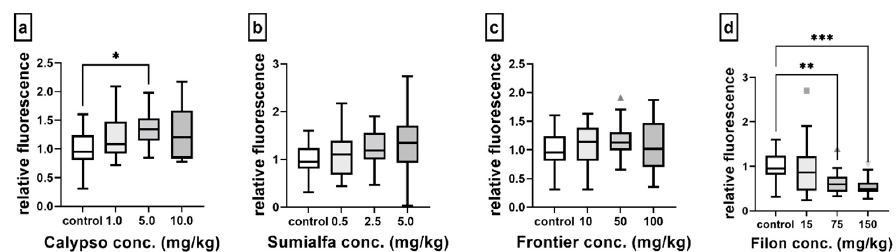
Figure 3. Results of GSH measurements after 48-h pesticide exposures in soil. Relative fluorescence for glutathione (GSH) measurements in E. andrei exposed to the investigated pesticide preparations ( a ) Calypso (active ingredient thiacloprid), ( b ) Sumialfa (active ingredient esfenvalerate), ( c ) Fron- tier (active ingredient dimethenamid-p), and ( d ) Filon (active ingredient prosulfocarb) for 48 h in LUFA 2.2 soil. Data is presented using Tukey’s boxplot ( n = 20). Significant differences (* p < 0.05, ** p < 0.01 and *** p < 0.001) between control and pesticide treatments are presented (ANOVA fol- lowed by Dunnett’s multiple comparison